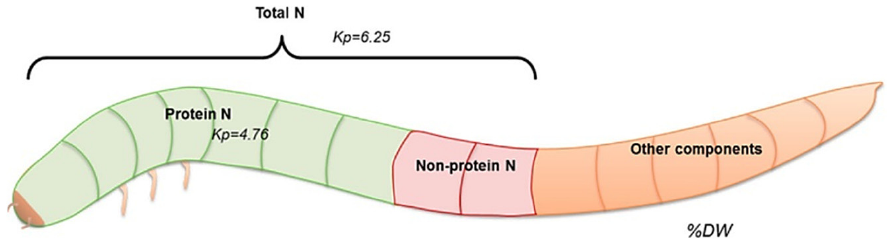
Figure 10. Insect larvae nitrogen-to-protein conversion factors [25].